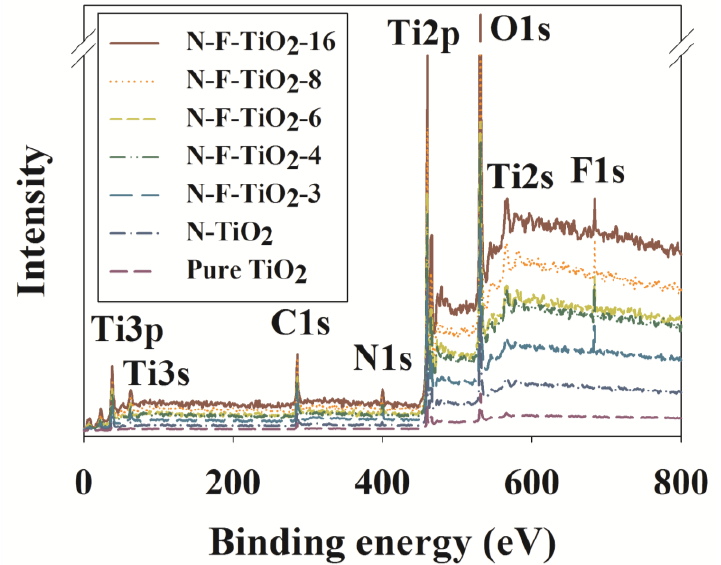
Figure 2. X-ray photoelectron spectroscopy of N–F–TiO 2 with different N:F ratios